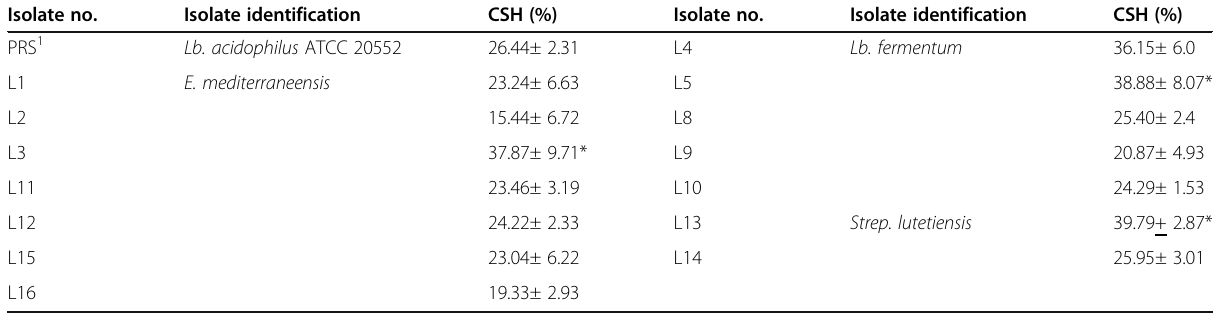
Table 6 Cell surface hydrophobicity (CSH) of isolated LAB Isolate